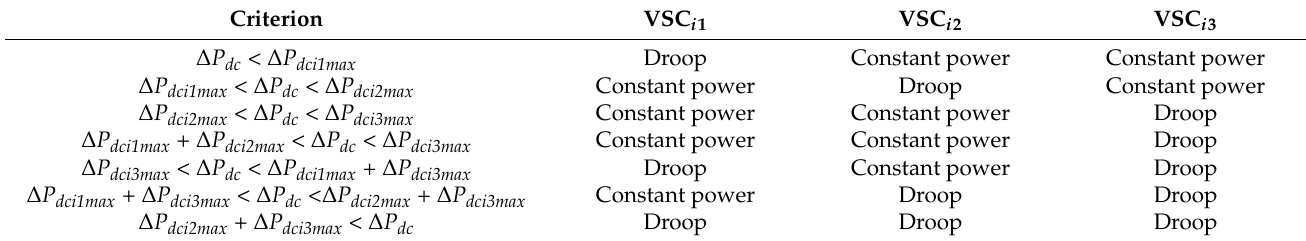
Table 1. Coordinated distribution strategy when the number of the active power control (APC) converter is three. Criterion VSC i 1 VSC i 2 VSC i